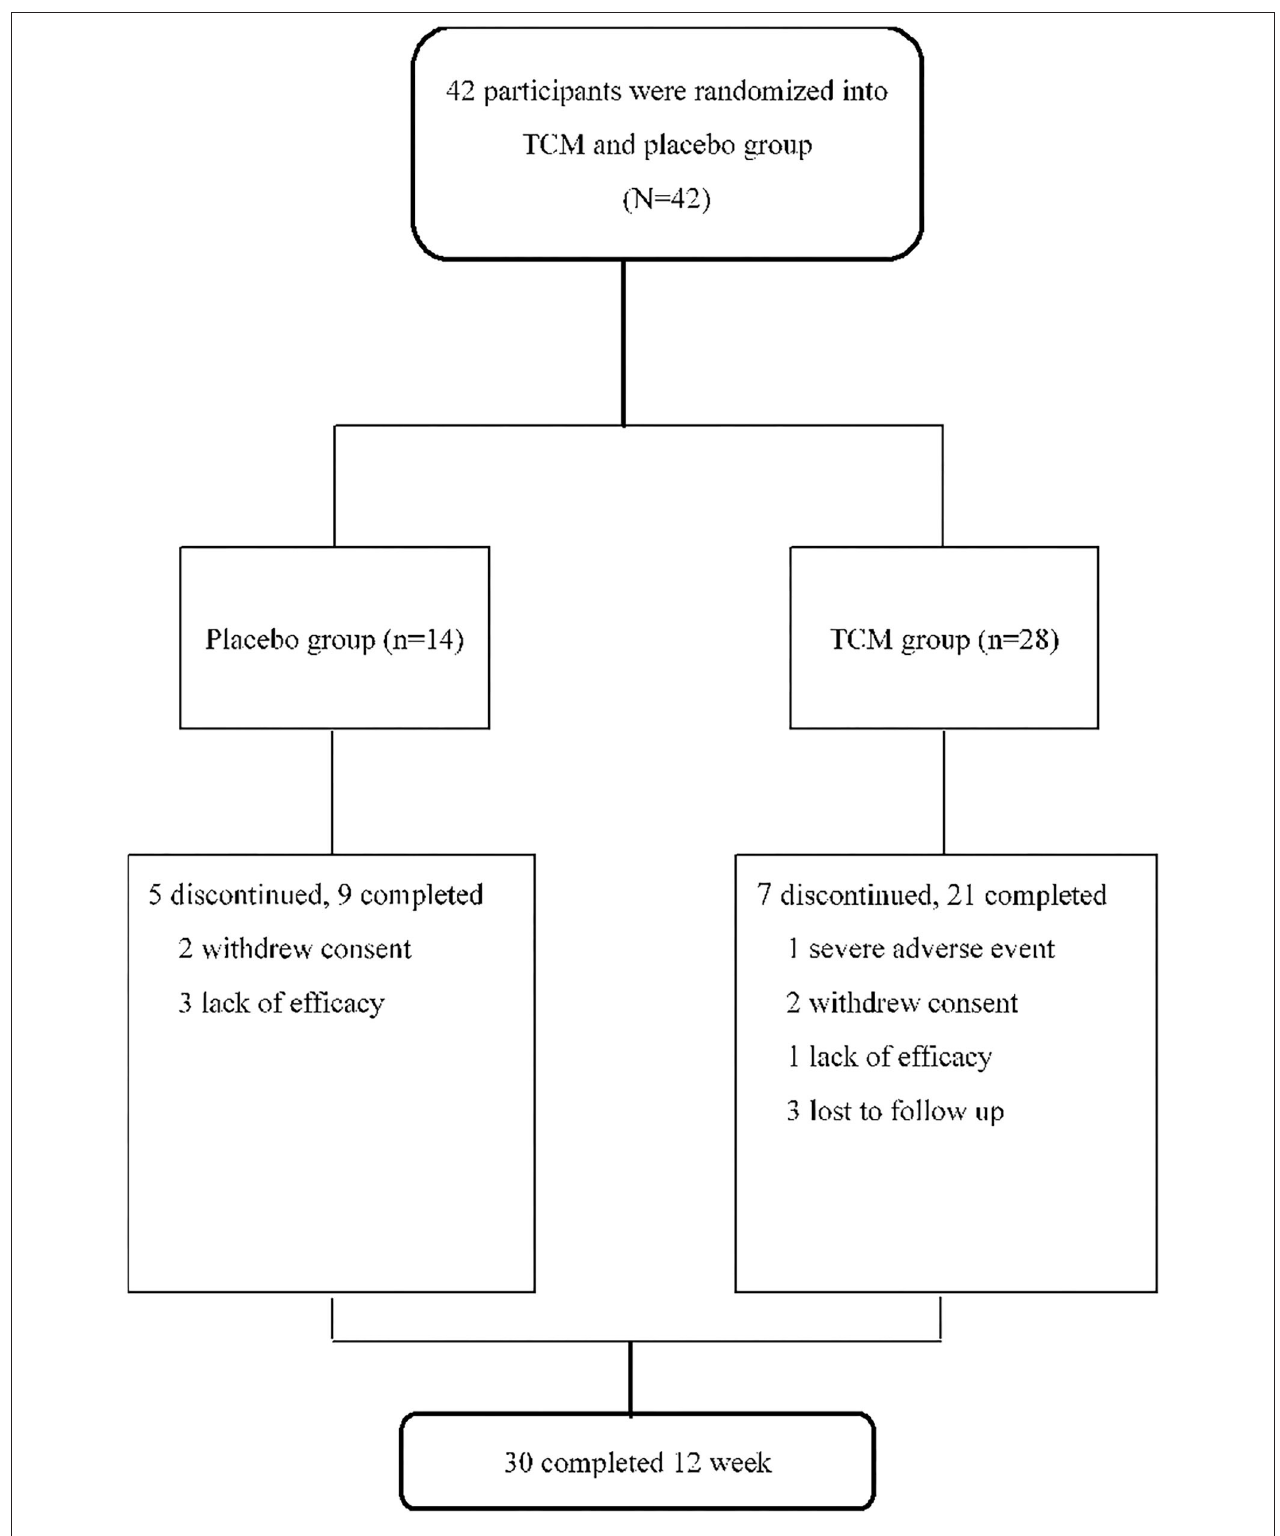
FIGURE 1 | Trial profile. 42 patients were randomized into TCM and placebo group in a ratio of 2:1. In the TCM group, 28 patients received 6 grams of Gan Lu Yin after breakfast, and 6g of Jia Wei Xiao Yao San combined with 1g of Suan Zao Ren and 1g of Ye Jiao Teng after dinner in the evening every day. 14 patients orally received placebo with one-tenth dose of TCM’s formula and the same appearance every day.